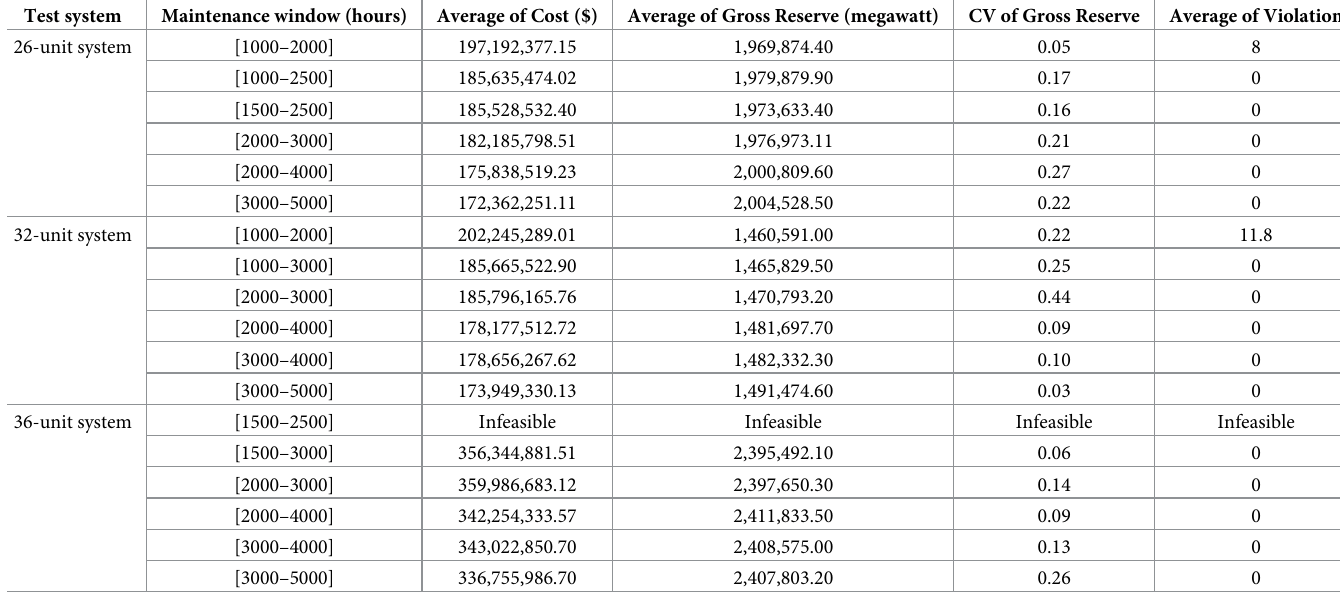
Table 10. Results of GMS model IV. Test